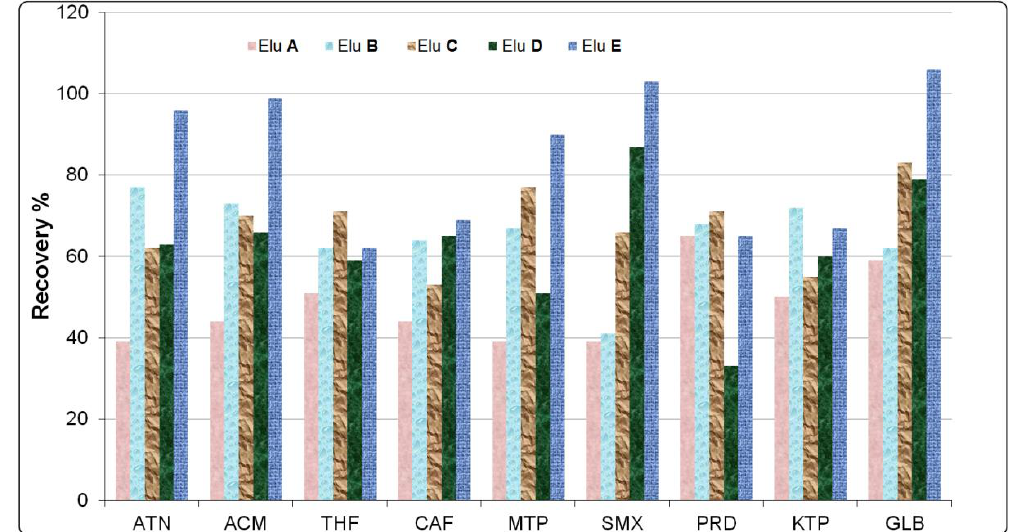
Figure 4. Influence of elution solvent on the recovery of the studied pharmaceuticals at 10 ng/mL of standards ( n = 3).